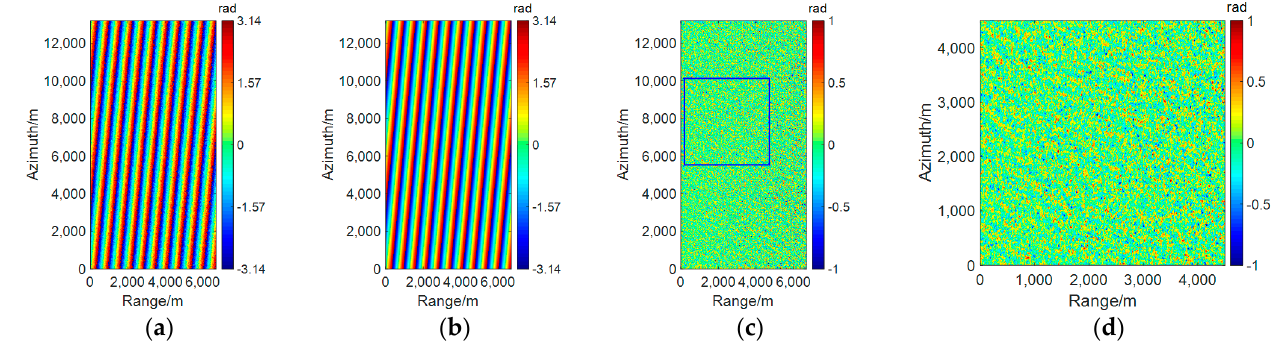
Figure 7. ( a ) The interferogram of the TerraSAR-X and TanDEM-X images; ( b ) the flat earth phase; ( c ) the interference phase after removing the flat earth phase, i.e., the interference phase caused by sea surface elevation and sea surface velocity; ( d ) the interference phase after removing the flat earth phase corresponding to the image in the blue box in ( c ).